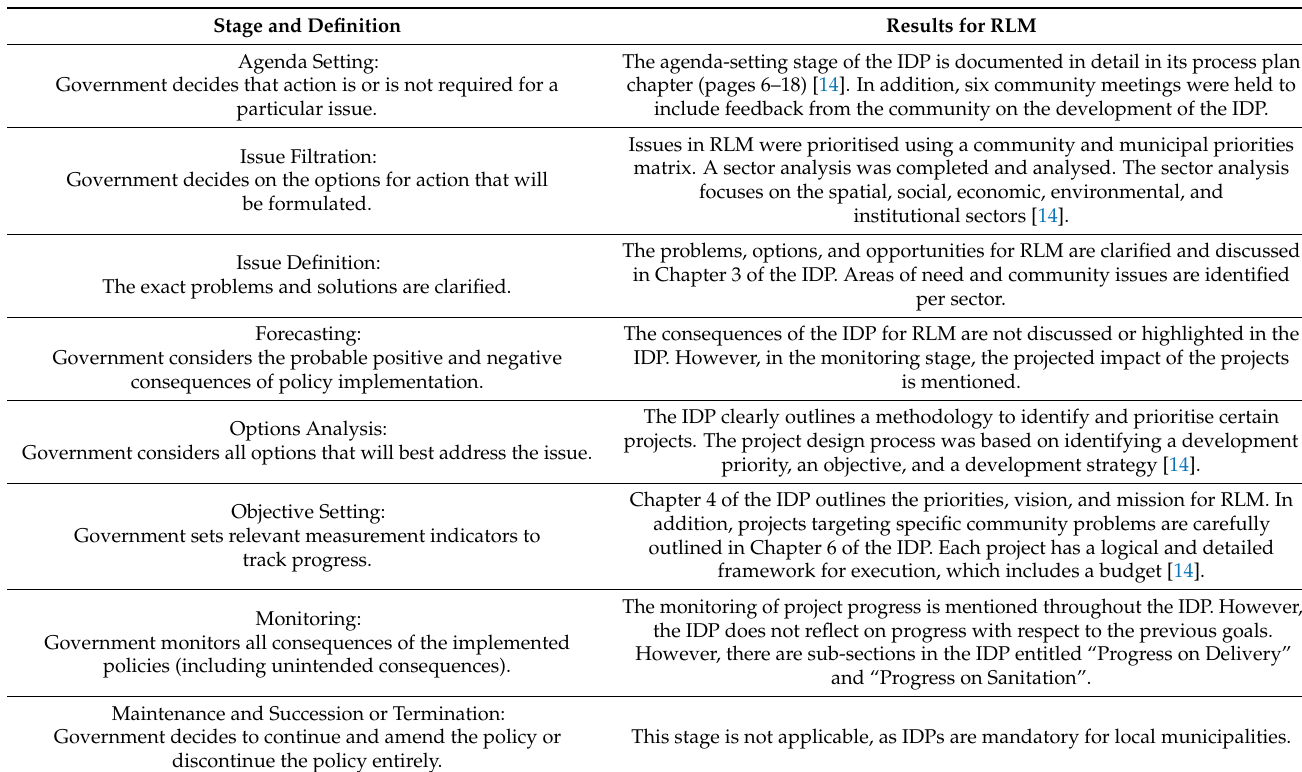
Table 11. IDP evaluation using Ryder’s (1996) 8-stage policy development